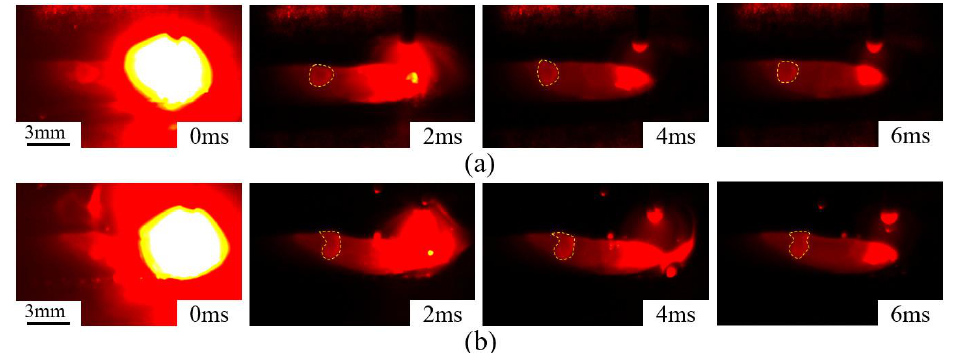
Figure 17. Effect of I p on the flow process of the welding pool and the morphology of molten slag in P-GMAW process: ( a ) I p = 485 A; ( b ) I p = 525 A.